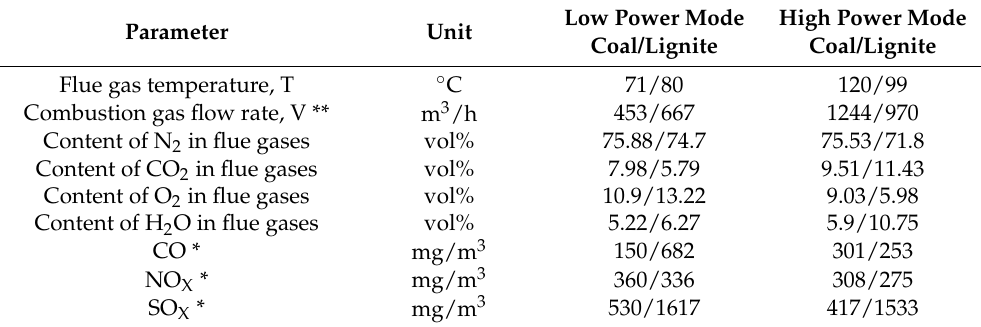
Table 3. Average experimental conditions for specific boiler regimes.